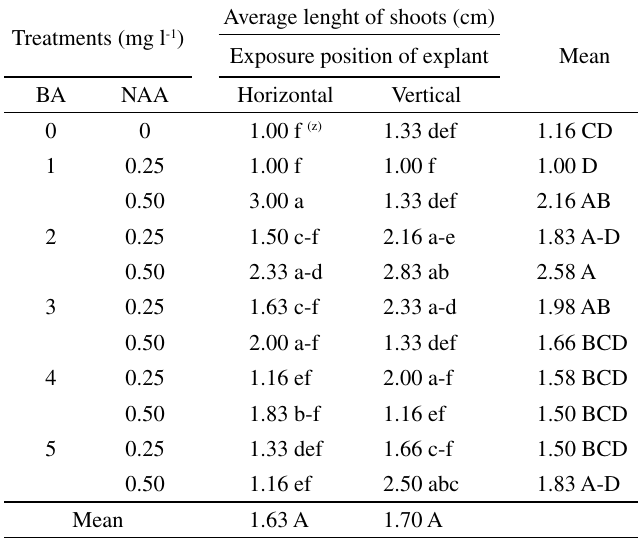
Table 8 - The interaction effect of different concentrations of BA and NAA, and exposure position of explants on the length of shoots in ‘Variegated’ Average lenght of shoots (cm) Treatments (mg l -1 )